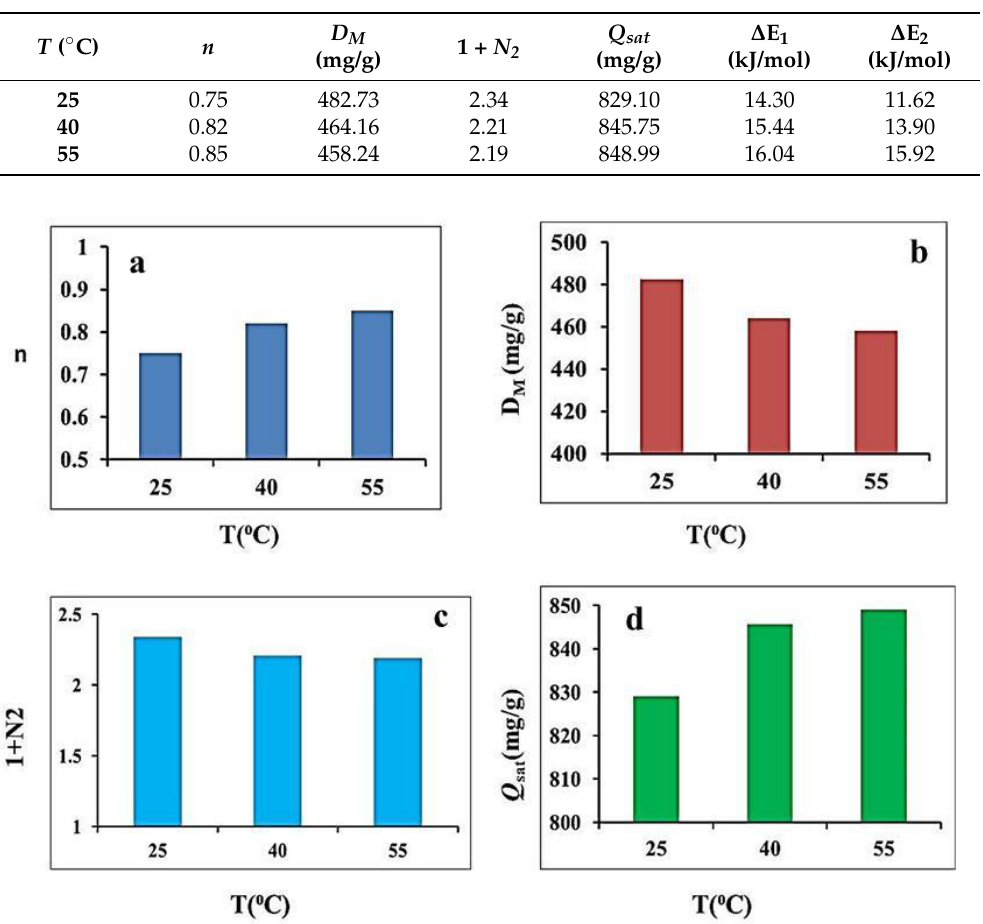
Figure 7. The behavior of the number of MB molecules per site ( a ), the density of receptor sites ( b ), the formed number of MB layers ( c ), and adsorption capacity at saturation ( d ) as a function of temperature for MB adsorption on the BE/SD–MNPs composite.